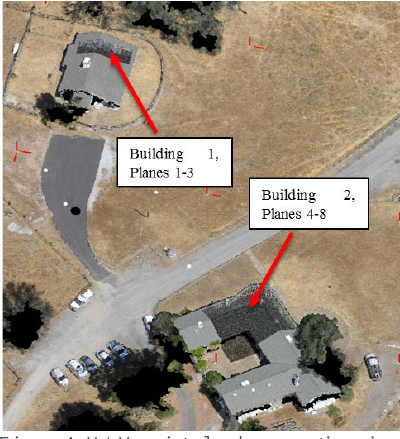
Figure 4: UAV point cloud perspective view.